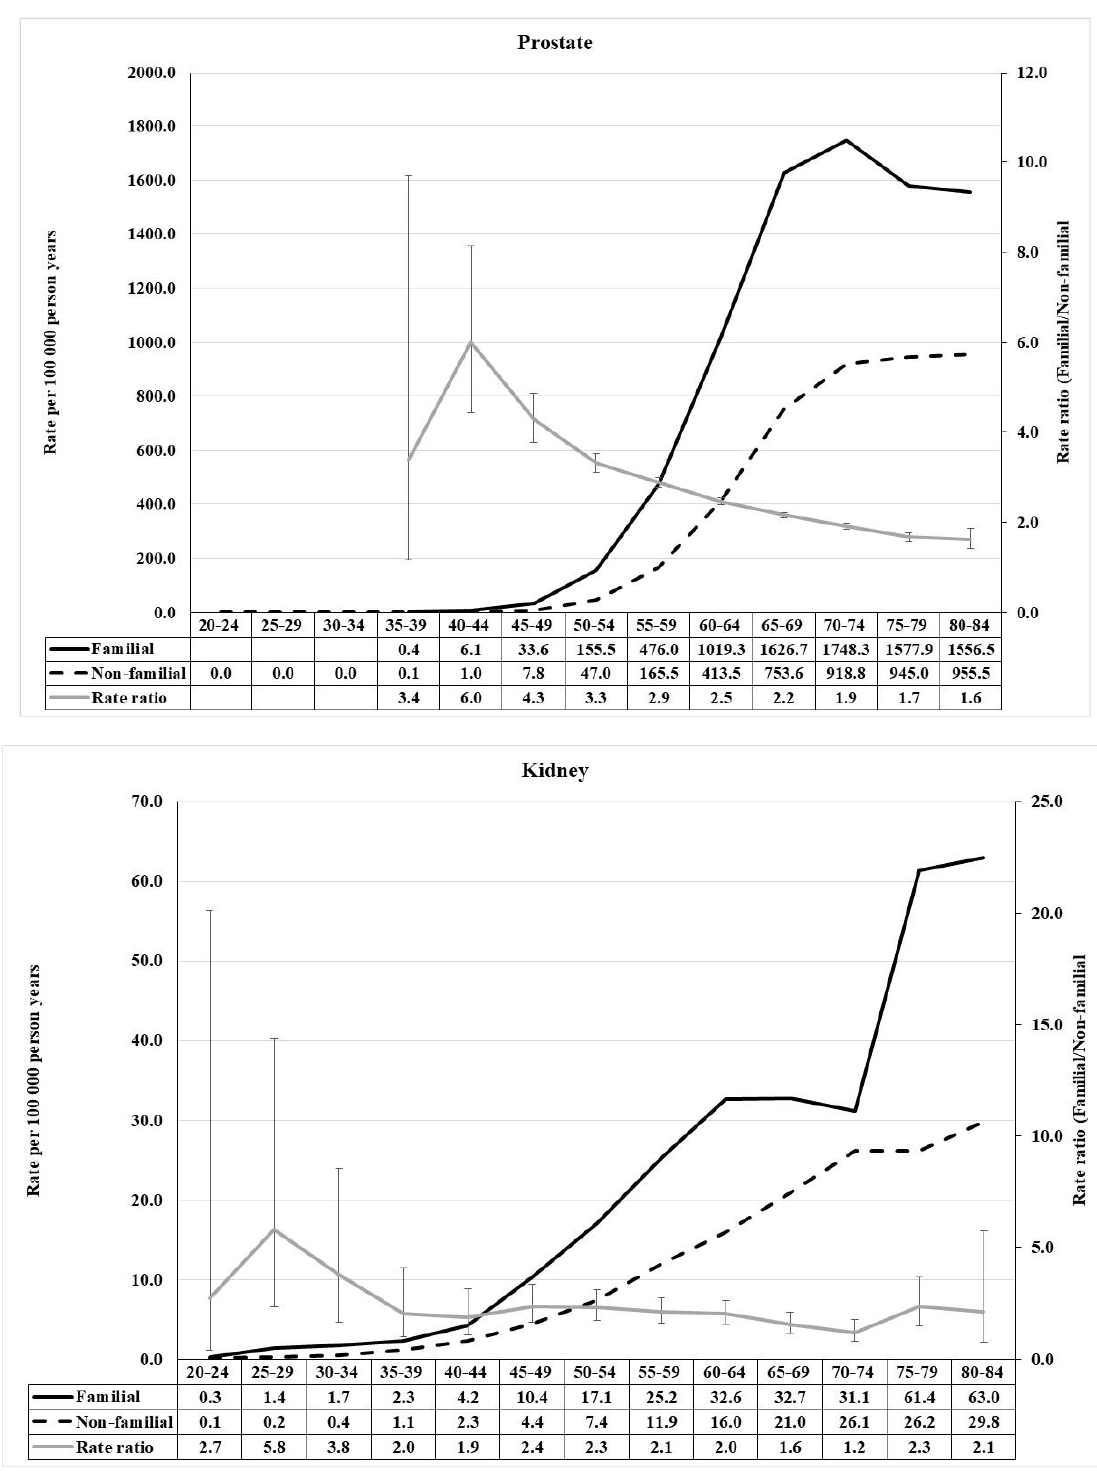
Figure 4. Age-specific incidence rate and rate ratio of prostate ( upper ) and kidney (renal parenchyma) ( lower ) cancer in population with and without family history of concordant cancer.